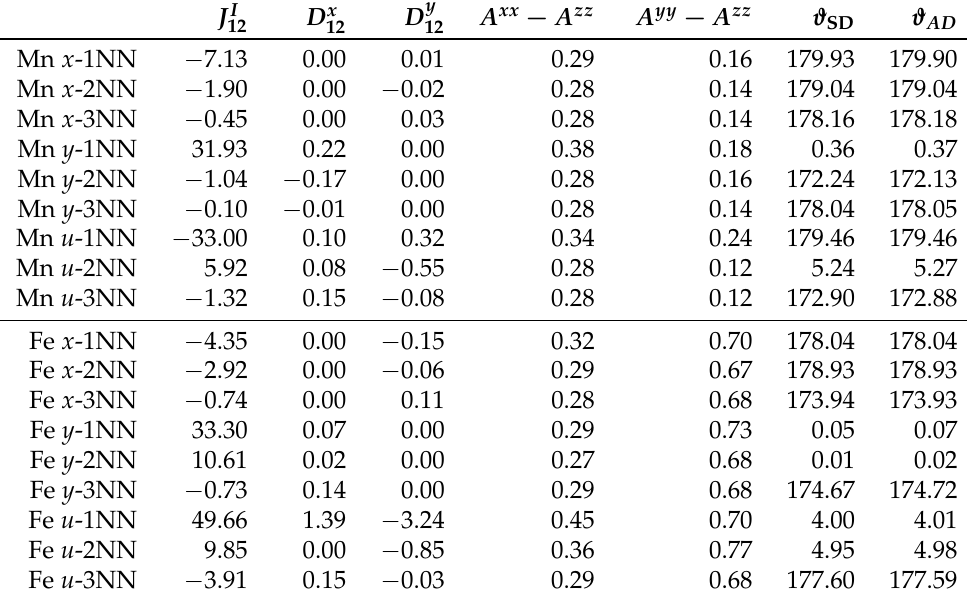
Table 1. Spin model parameters in units of meV and ground state spin angles in degrees for the Mn and Fe dimers. The isotropic interactions J I (positive and negative values mean FM and AFM ij coupling, respectively), DM interaction vectors (cid:126) D ij and anisotropy matrix elements A are shown. = 0 holds for all the dimers. ϑ SD is the ground Note that A also includes the two-site anisotropy. D z 12 state angle based on spin dynamics simulations, and ϑ AD is the approximate ground state spin angle calculated using the spin model parameters (see Appendix A). The ϑ SD angles of the Mn u -1NN, Mn x -1NN, and Mn y -2NN dimers were reported in